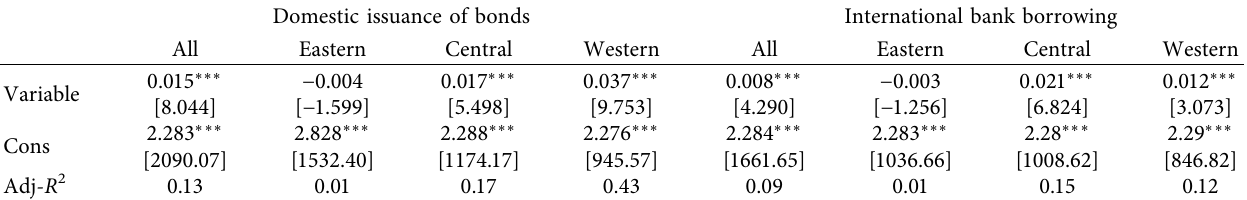
Table 10: Overall governance efects of borrowing